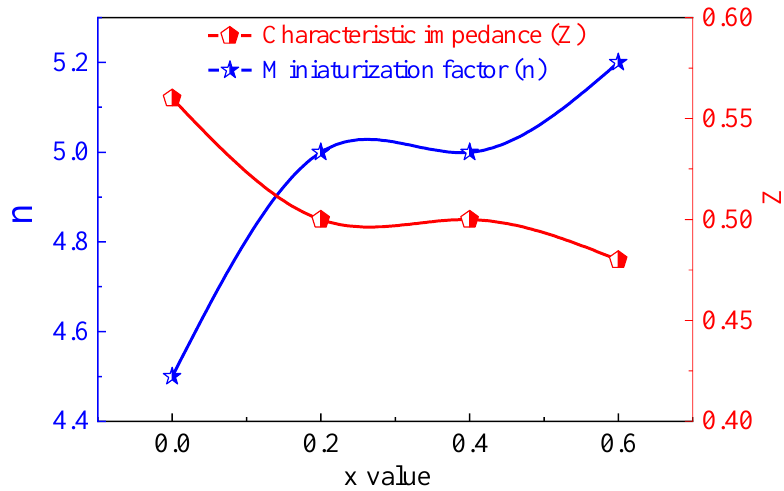
Figure 5. Miniaturisation factor ( n ) and relative impedance ( Z ) of CO (2) Z ferrites with various x values.